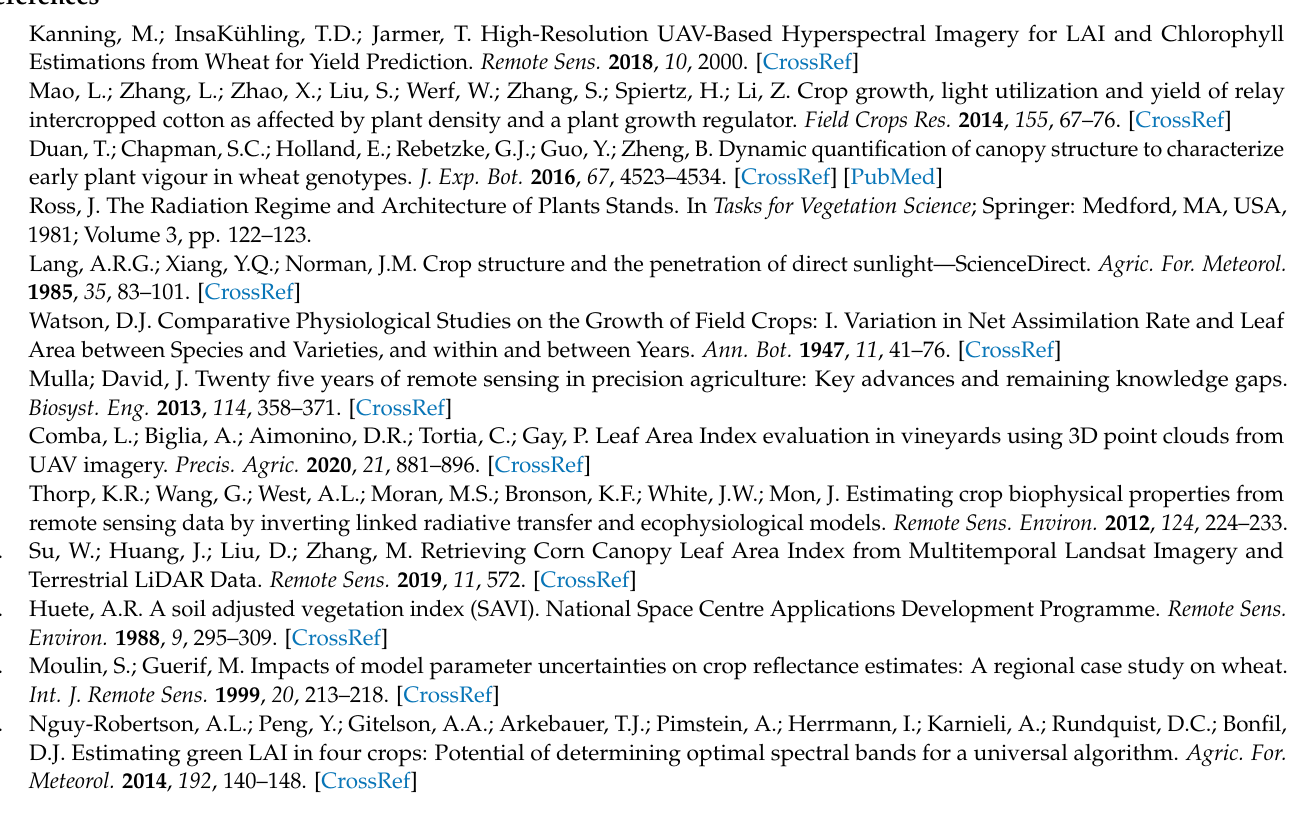
Figure S4: Effects of input vegetation indices on the model accuracy using the PROSAIL model simulation; Figure S5: Performance of machine learning algorithms combined with optimized input indices using the PROSIAL model simulations; Table S1: Statistics of estimated MTA data using simulated Sentinel-2 bands which have 10 m resolution; Table S2: Statistics of estimated MTA data using simulated Sentinel-2 bands which have 20 m resolution; Table S3: Statistics of estimated MTA data using machine learning algorithms combined with optimized input